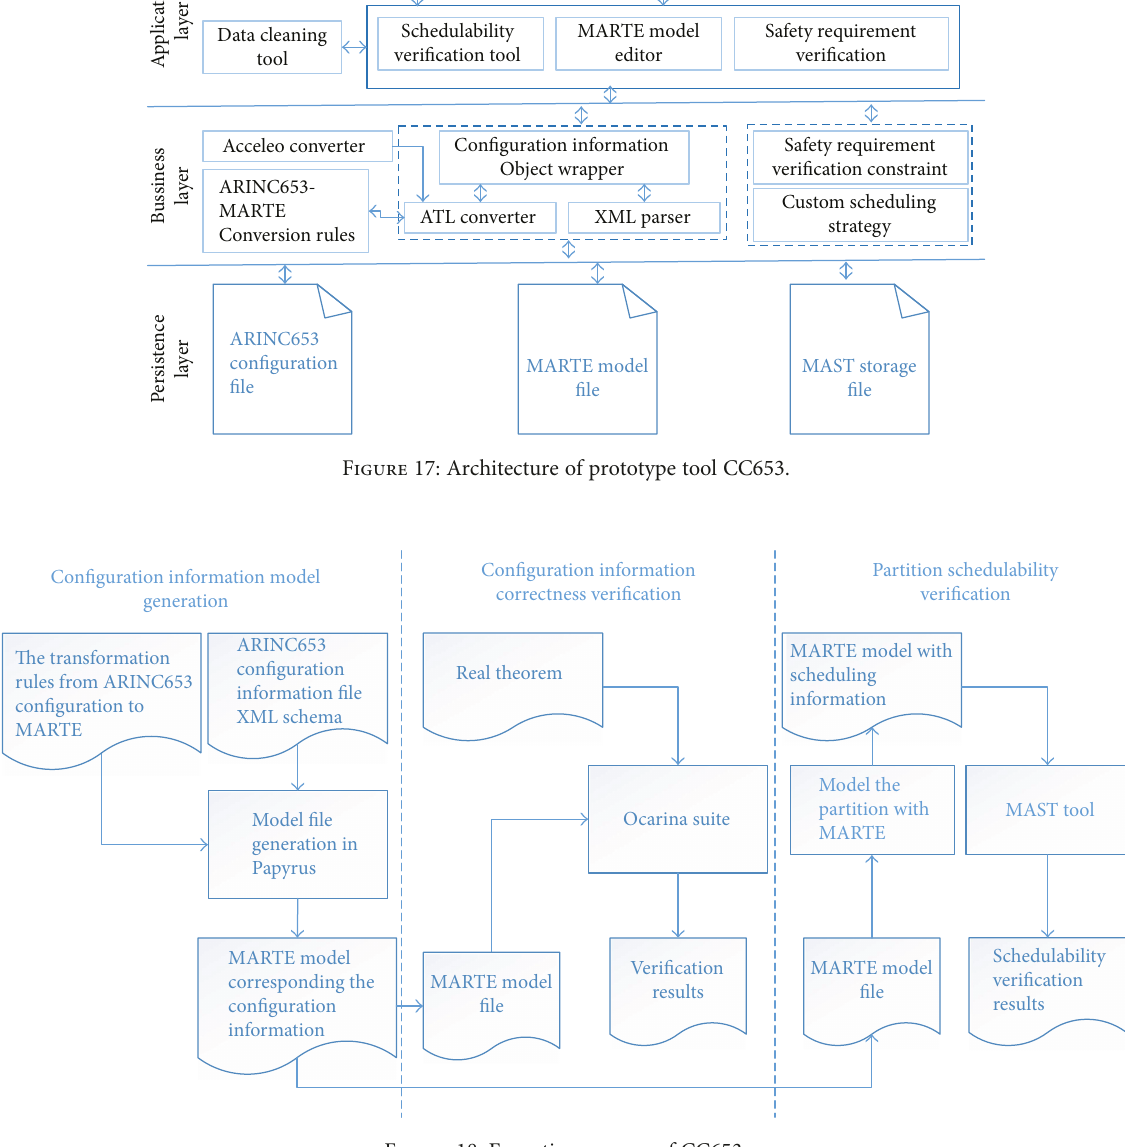
Figure 18: Execution process of